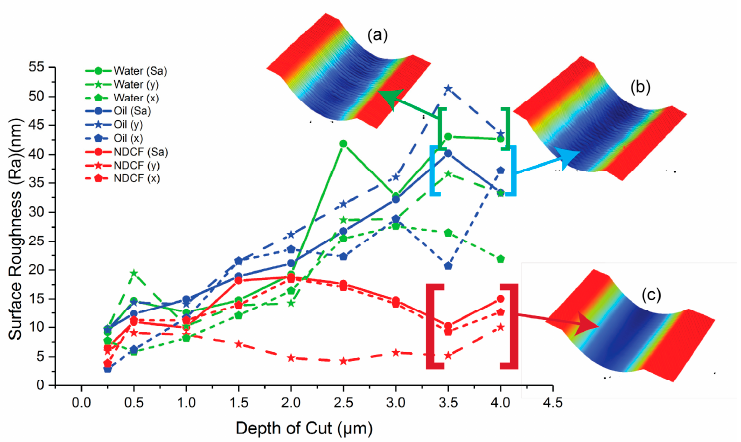
Figure 6. Ra(x), Ra(y), and Sa of the diamond-turned Polymethylmethacrylate (PMMA) with different cutting fluids, with samples of 2D profiles cut with ( a ) water, ( b ) oil, and ( c ) NDCF.